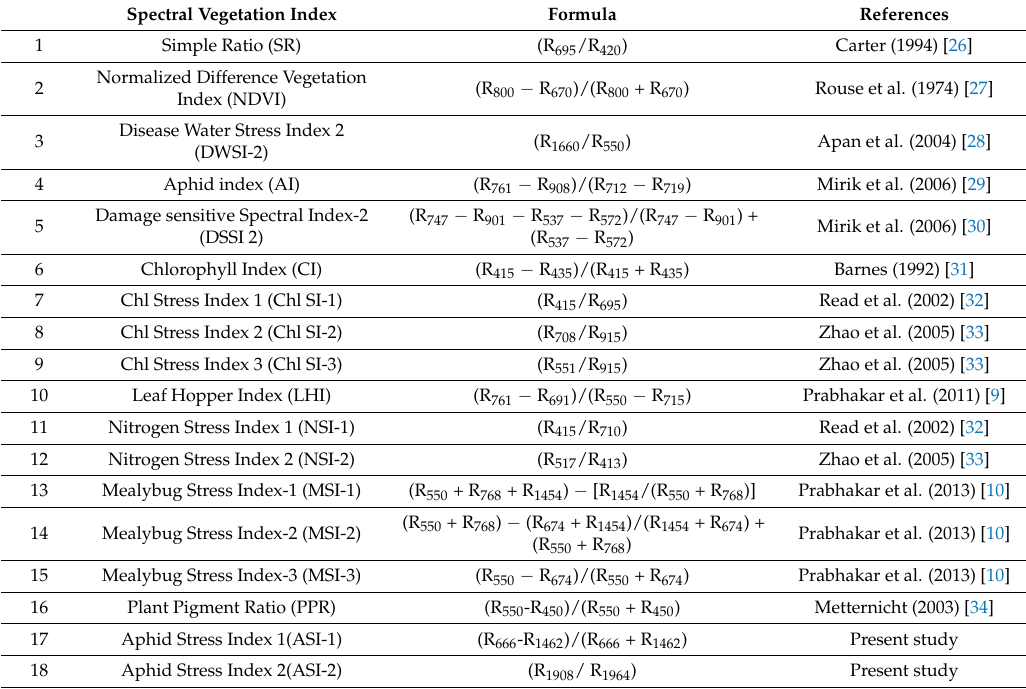
Table 3. Vegetation indices used in this